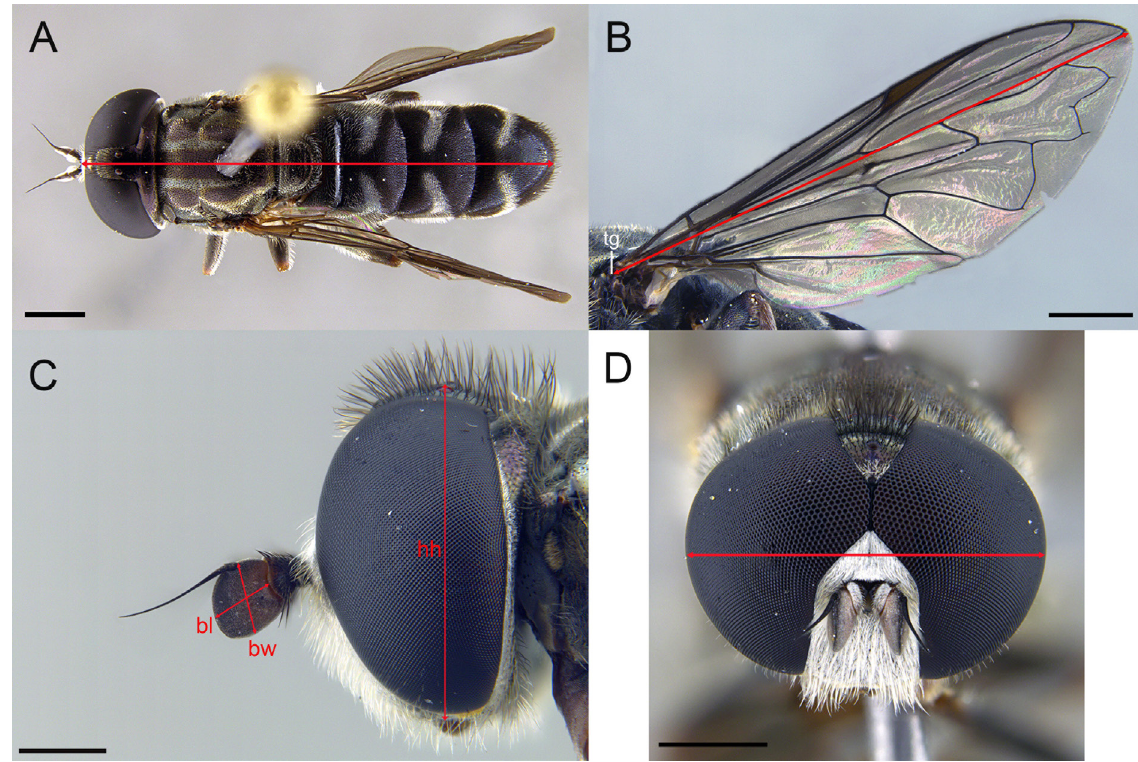
Fig. 4. Measurements of Eumerus colladoi Ricarte & Aguado-Aranda sp. nov. A, C–D . Holotype, ♂ (CEUA-CIBIO). B. Paratype, ♀ (CEUA-CIBIO). Abbreviations: bl = basoflagellomere length; bw = basoflagellomere width; hh = head height; hw = head width; l = body length; tg = tegula; w = body width; wl = wing length. Scale bars: A–B = 1 mm; C–D =